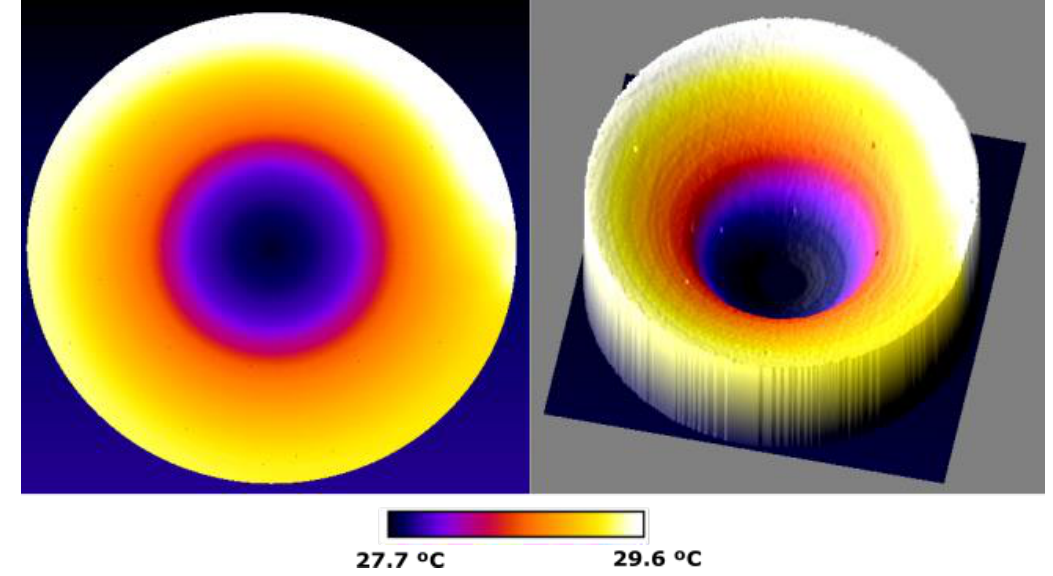
Figure 16. 3D representation of the temperature corresponding to the simulation with the CM at the instant of 250 s, h eff (Cu) = 8.4, h eff (Fe) = 30 W/m 2 K, d = 3 mm and w r = 15.7 rad/s.